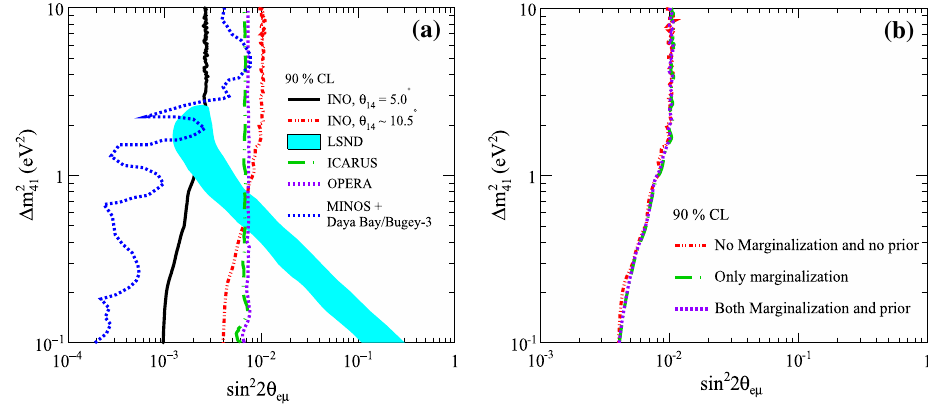
− sin 2 2 θ Fig. 8 a The 90% exclusion limits in the (cid:2) m 2 e μ plane 41 U 2 μ where sin 2 2 θ e μ = 4 U 2 , expected from an exposure of 1Mt-yr of e 4 4 the ICAL data. The active–sterile mixing angles are considered fixed at ◦ θ = 5 . 0 ◦ and10.5 ◦ and θ 14 34 =0.0